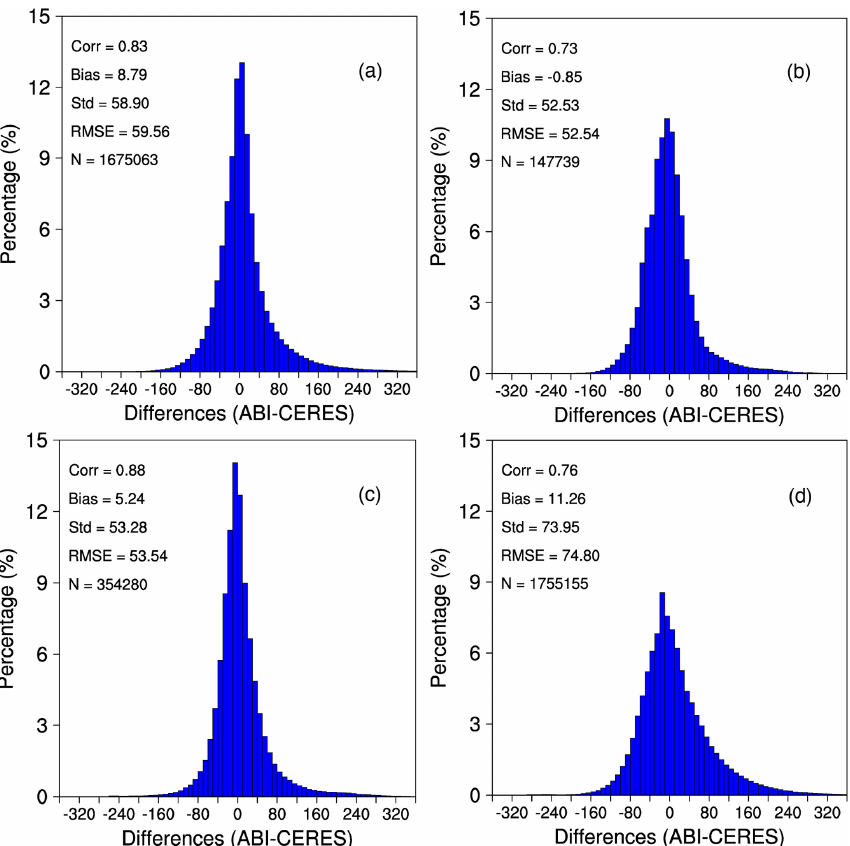
Figure 12. Frequency distribution of all-sky TOA SW differences between (a) ABI on GOES-16 and CERES_SSF using Aqua and between (b) ABI on GOES-17 and CERES_SSF using Aqua. (c) The same as (a) using Terra and (d) the same as (b) using Terra. All observations were used (clear and cloudy) on 26 December 2019 at